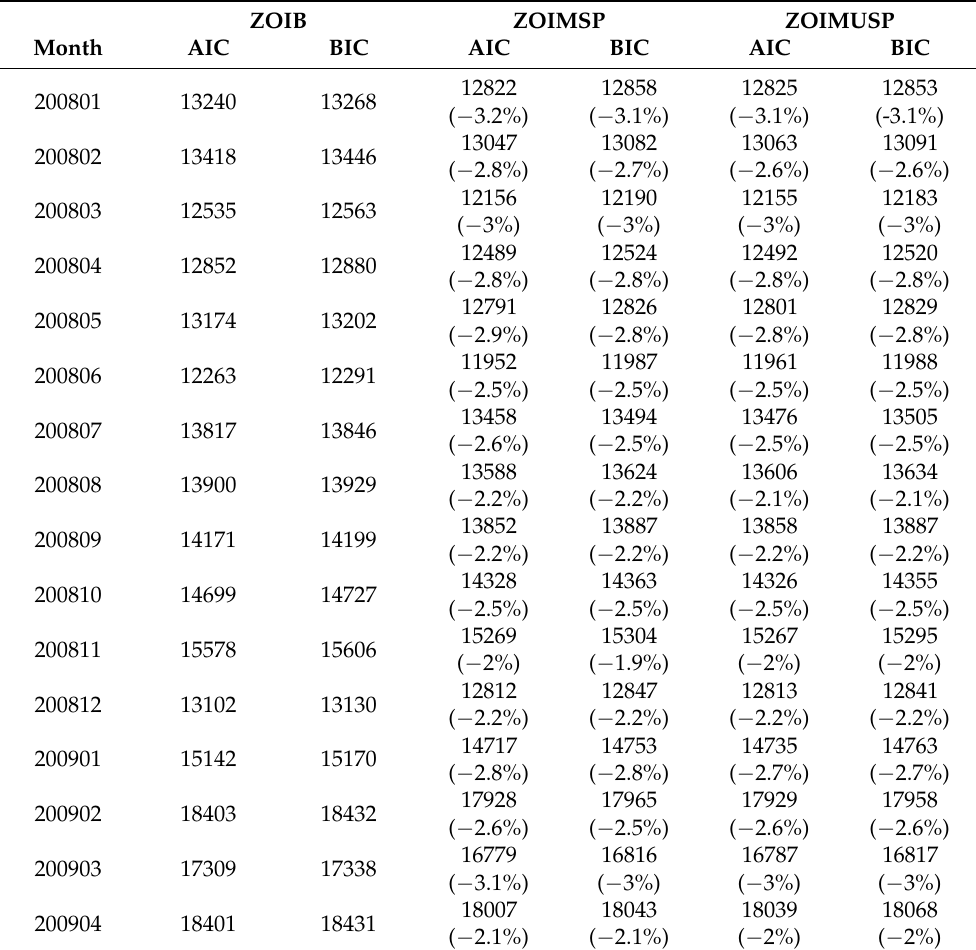
Table 5. Information criteria for the fitted ZOIMSP and ZOIMUSP models compared to the ZOIB